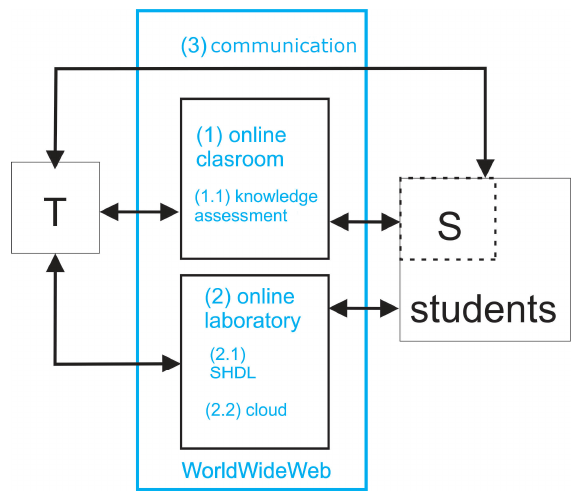
Figure 5. Proposed model for DESD online teaching purpose; T—teacher; S—student.